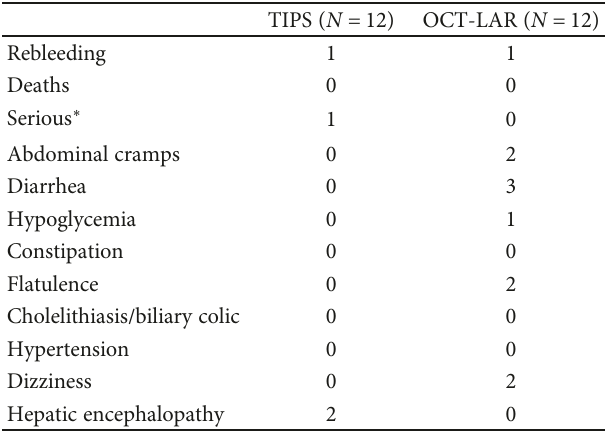
Table 6: Treatment